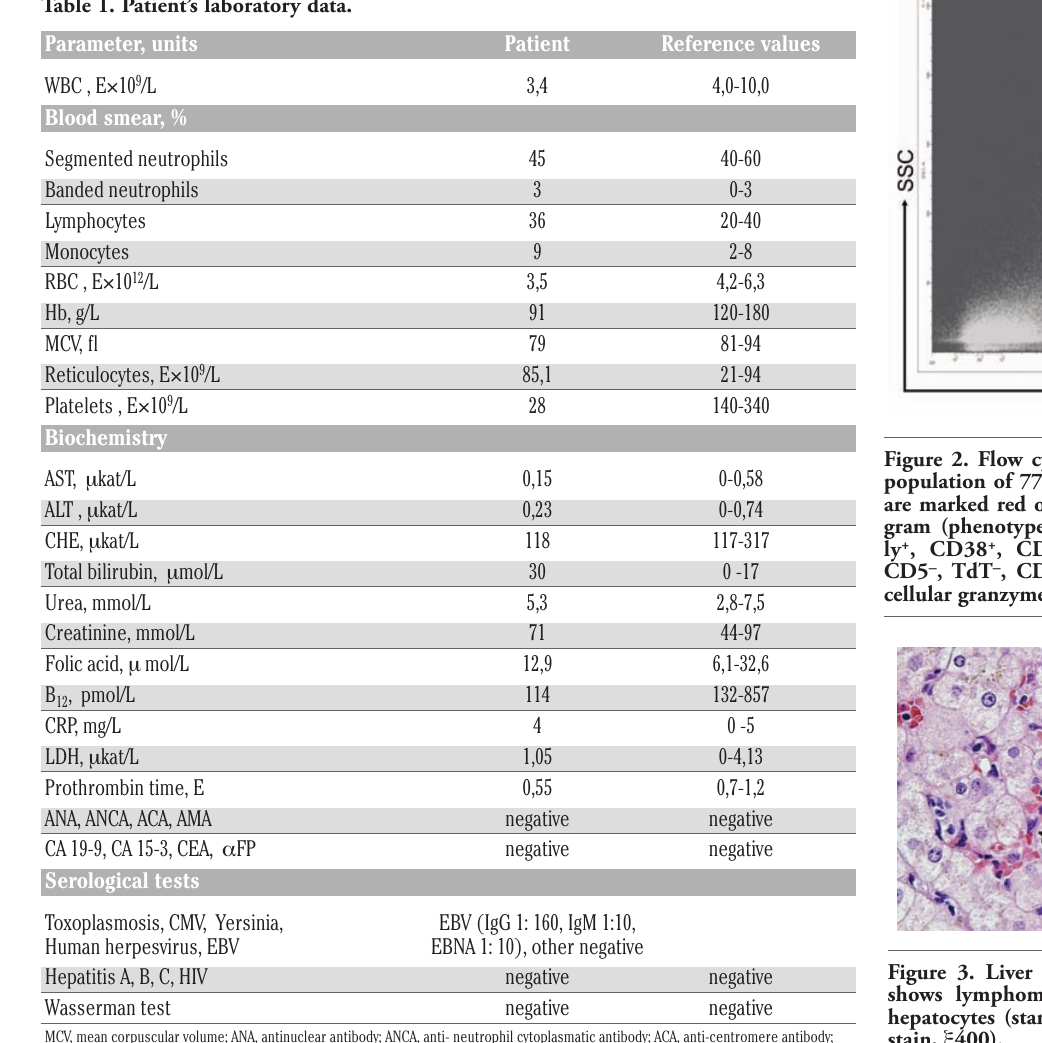
Table 1. Patient’s laboratory data.